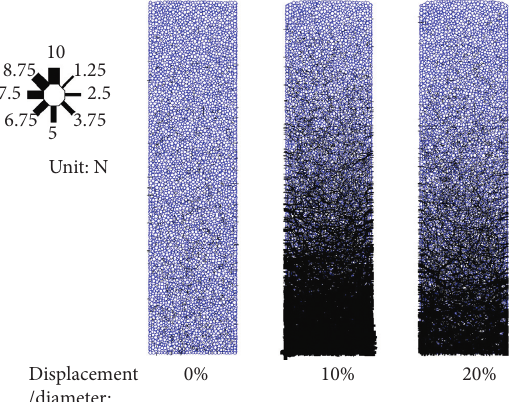
Displacement /diameter: Figure 10: Particle contact force transmission in a pipe pile ( D � 10cm and L / D �